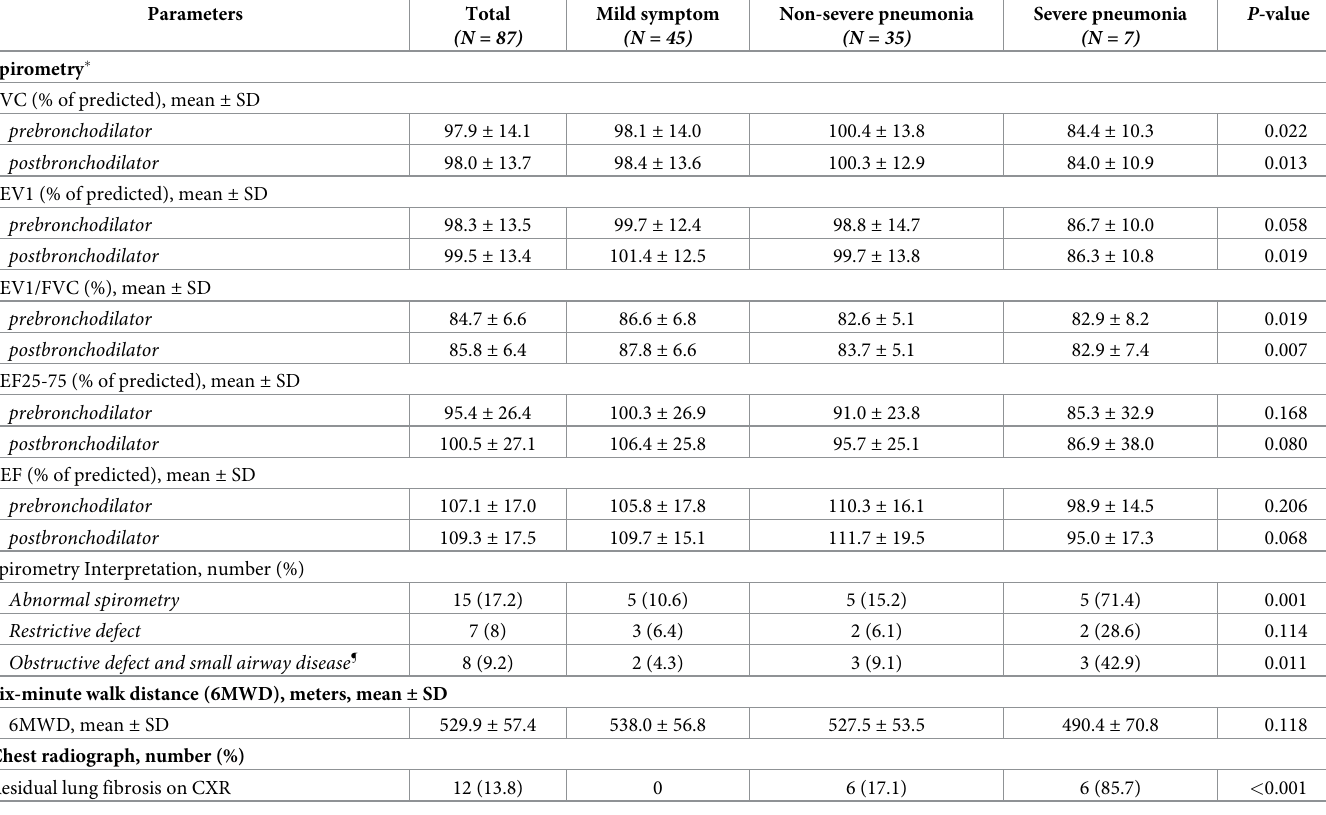
Table 2. Results of pulmonary function tests, 6MWT and chest x-ray.